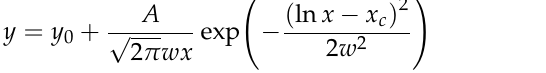
Table 5. The coefficients of LogNormal and eigenvalues of the trajectory oscillation index.